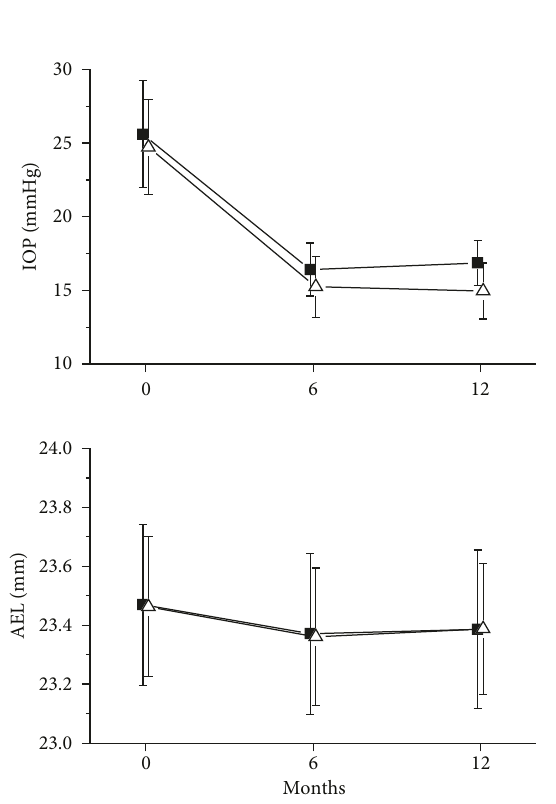
Figure 1: E ff ectoftrabeculectomyonintraocularpressure(IOP)and axial eye length (AEL) in patients undergoing phacoemulsi fi cation before trabeculectomy (group A, n = 21 , open up triangles) and in patients undergoing trabeculectomy before phacoemulsi fi cation (group B, n = 27 , solid squares). Data are presented as means ±